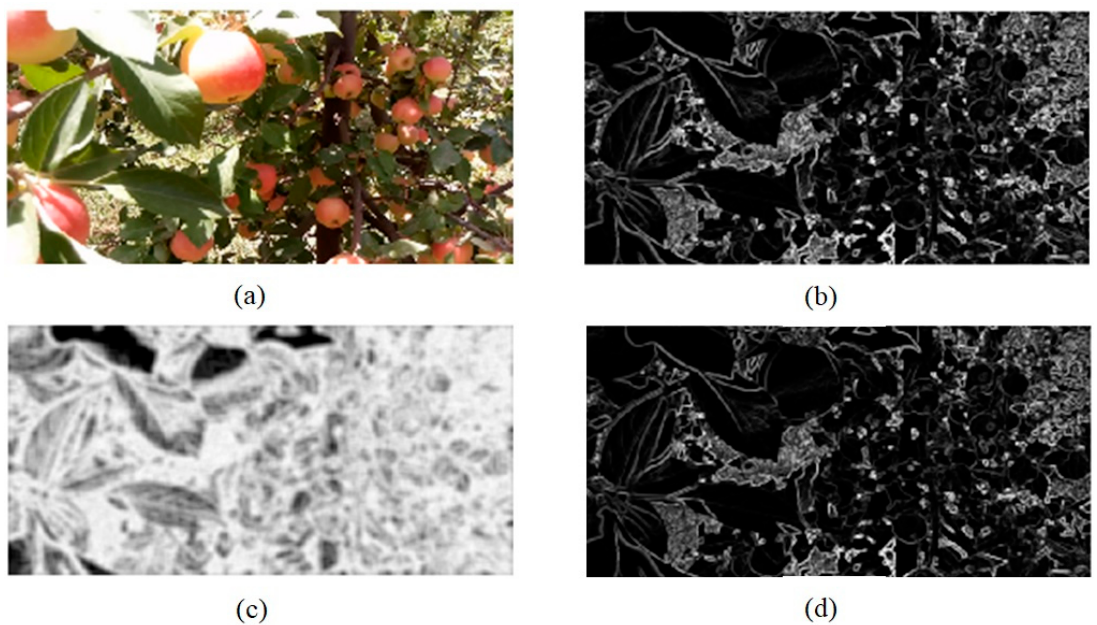
Figure 3. Texture feature with high performance in the second segmentation process. ( a ): The original image, ( b ): The image obtained by applying the local range feature, ( c ): The image obtained by applying the local entropy feature, ( d ): The image obtained by applying the local standard deviation feature.